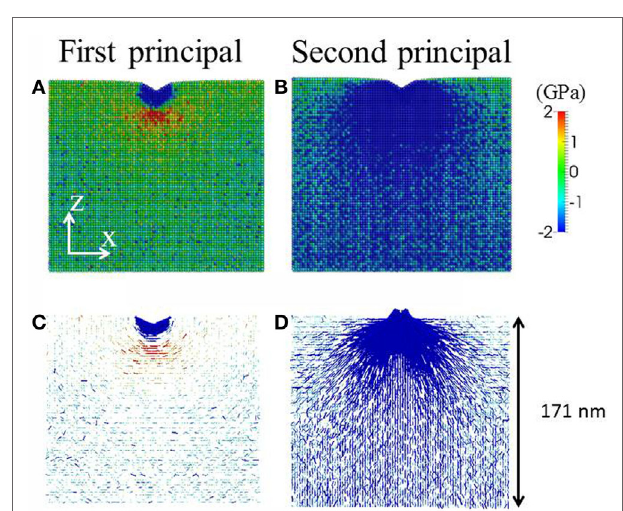
FigUre 2 | example representations of in-plane stress field under indentation with penetration depth of 10 nm and indenter angle of 120° . First principal stress field is shown in (a,c) and second principal stress field in (B,D) . In (a,B) , the magnitude of the local stress field averaged over 2 nm × 3 nm × 2 nm voxels is denoted by the color bar. Tensile stress is positive and compressive stress is negative. In (c,D) , in addition to the color, the direction of the stress is denoted by the line. The length of the line is proportional to the magnitude of the stress. The sample size is chosen so that the indentation stress field is away from the boundary of the simulation box. In the rest of the paper, close-up views of first principal stress field with overlapping color and line representations will be